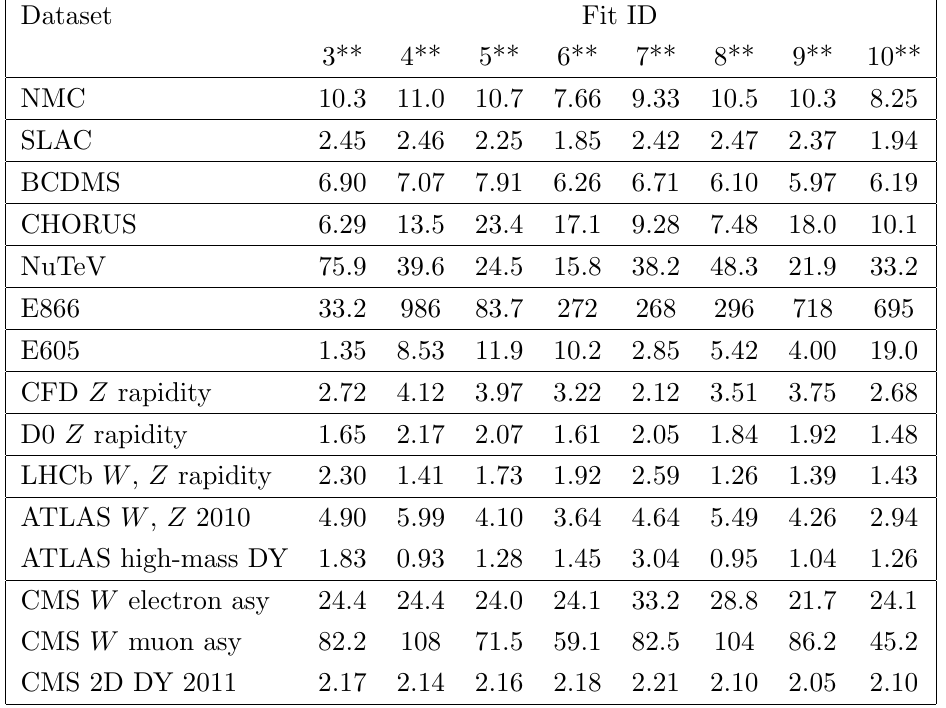
Table 11 . Same as table 10, but for the HERA-only (cid:12)ts including CMS top-pair di(cid:11)erential